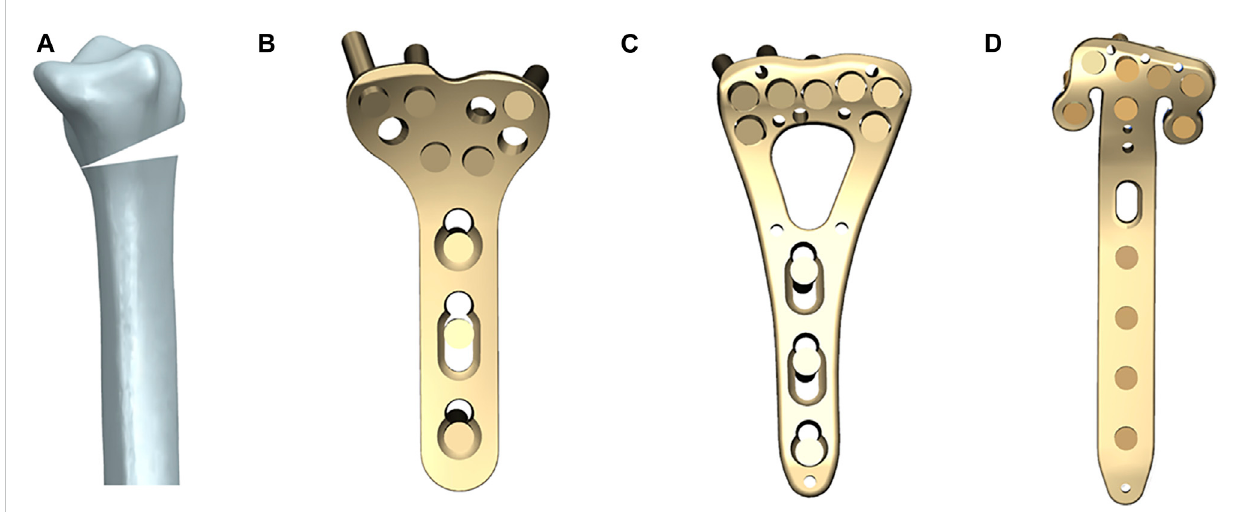
FIGURE 1 The models of a distal radius fracture and three volar plates (all from Depuy Synthes, West Chester, PA, United States, Ti6Al4V). (A) AO type 23-A3 distal radius fracture built by a 10 mm dorsal wedge osteotomy; (B) 2.4 mm LCP Volar Distal Radius Plate (T plate); (C) 2.4 mm LCP Two-Column Volar Distal Radius Plate (V plate); (D) 2.4 mm Volar Rim Distal Radius Plate ( π Plate).